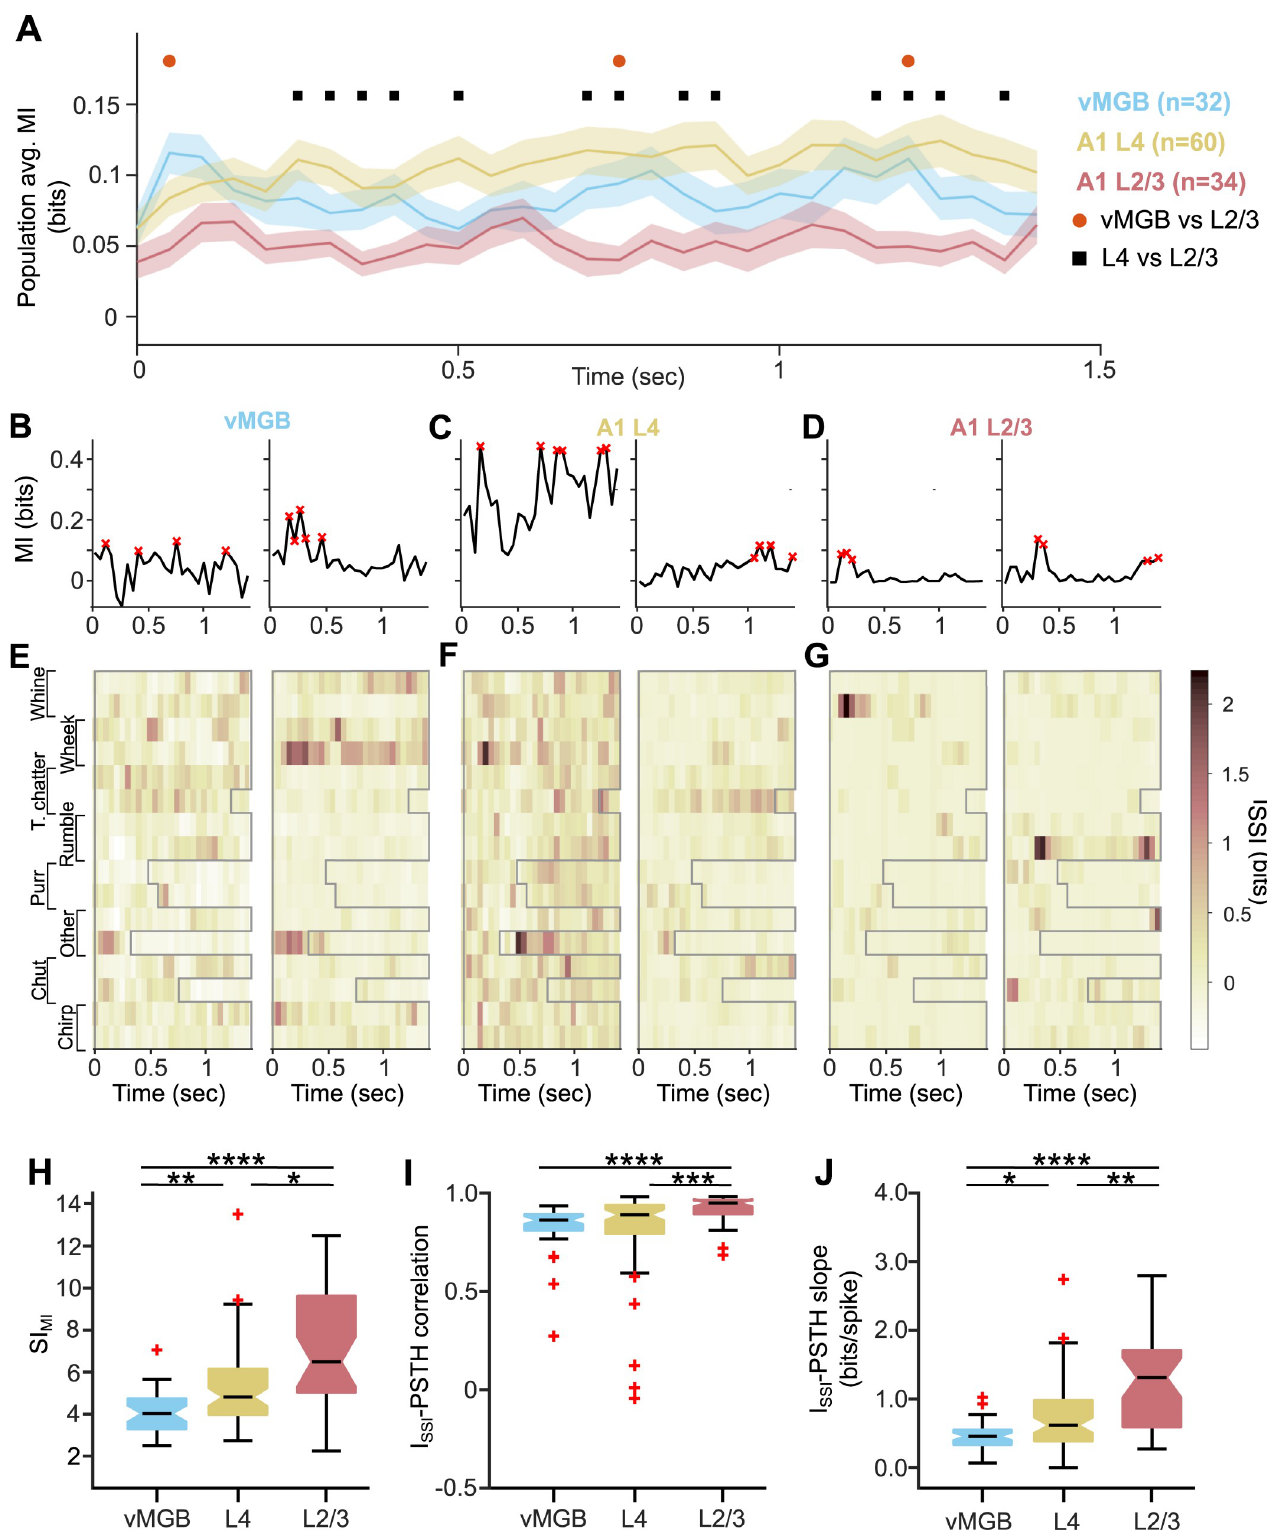
Fig 8. Reformatting of stimulus information in A1 L2/3. (A) Population average of MI as a function of time in vMGB (blue), A1 L4 (yellow), and A1 L2/3 (red) neurons. Lines correspond to means and shading to 1 SEM. Colored dots represent results of statistical testing ( p < 0.05; two-sided t test with FDR